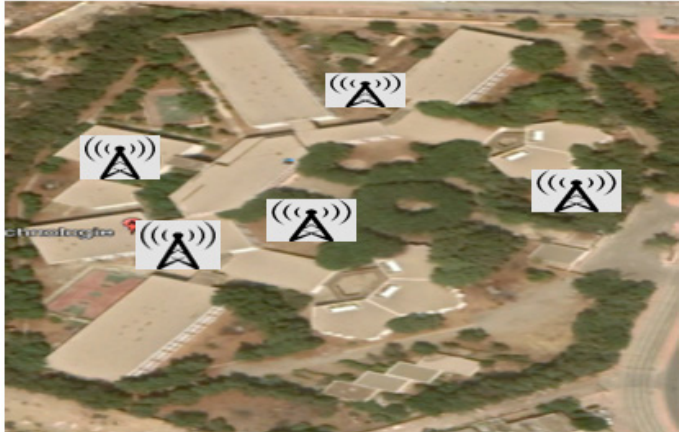
Figure 4. Geographic map of the ENST campus (Algiers, Algeria).